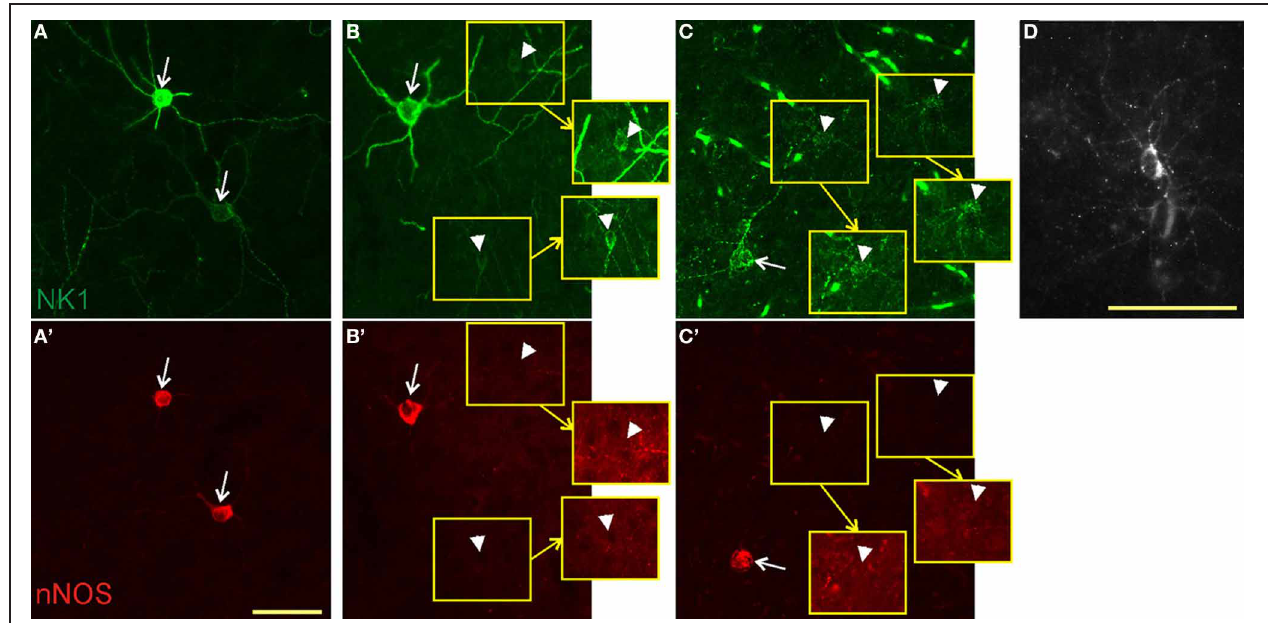
the other species, whereas neurons single-labeled for NK1 had round somata surrounded by short, thin, highly arborized dendrites. Fluorescent blood vessels are visible because monkeys were not perfused before fixation. The punctate pattern of NK1 labeling in C and the bottom cell in A is typical for NK1 endocytosis upon ligand binding. (D) A single-labeled NK1 neuron of monkey cortex at higher magnification for better visibility of the morphology. Note the highly arborized, short dendrites. Scale bars denote 50 μ m. Micrographs were taken as monochrome pictures and pseudocolored for representation.